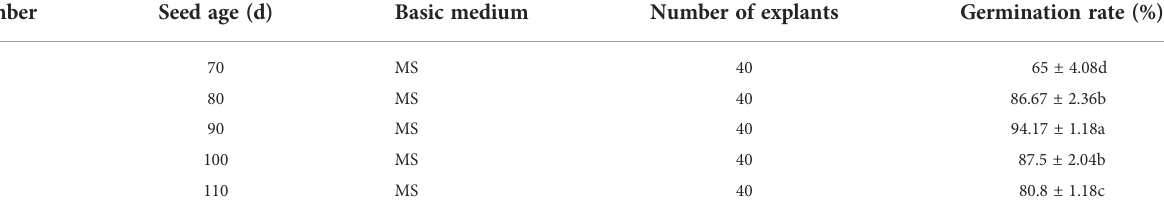
TABLE 2 Peony embryo germination at different developmental stages.